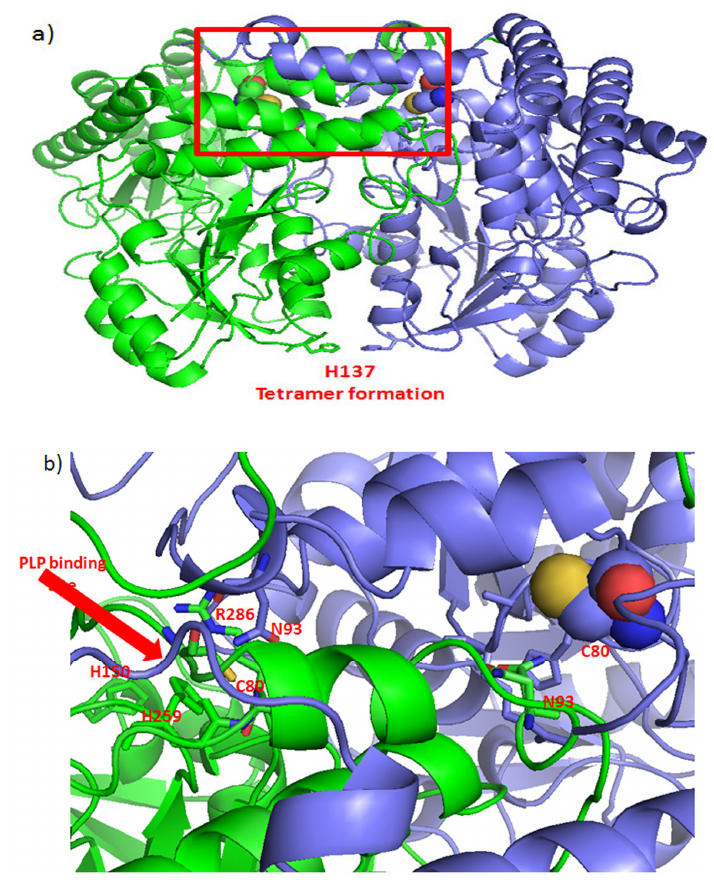
Figure 3. Possible effects of curcumin’s binding to SHMT2 Cys80. ( a ) The symmetric dimer of SHMT2 (PDB: 4PVF) showing amino acid residues Cys80 (spheres) and His137 (sticks) participated in the tetramer formation [128]. Monomers are shown in green and purple. ( b ) The part of the 4PVF structure within red rectangular in ( a ), with marked amino acid residues making interactions with the nonmodified Cys80. The pyridoxal 5’-phosphate (PLP) binding site is encompassed by marked His150 and His259.